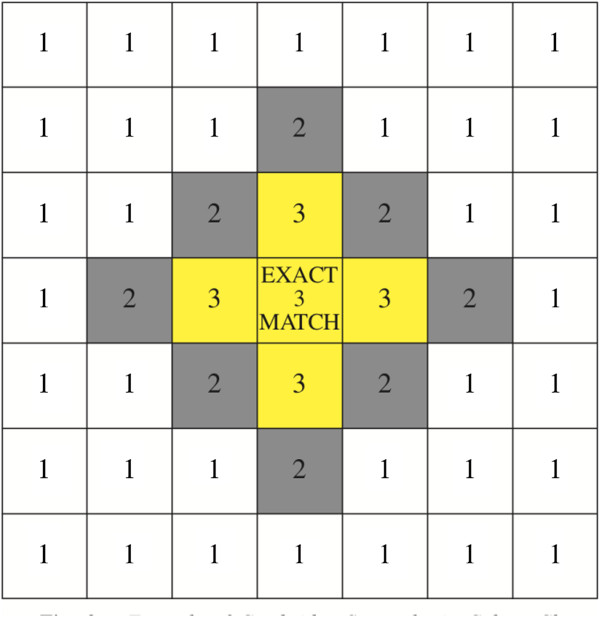
Scoring protocol for the ToG-R. Each box represents a swatch on the colour chart. From Asher et al. (2006) [32].